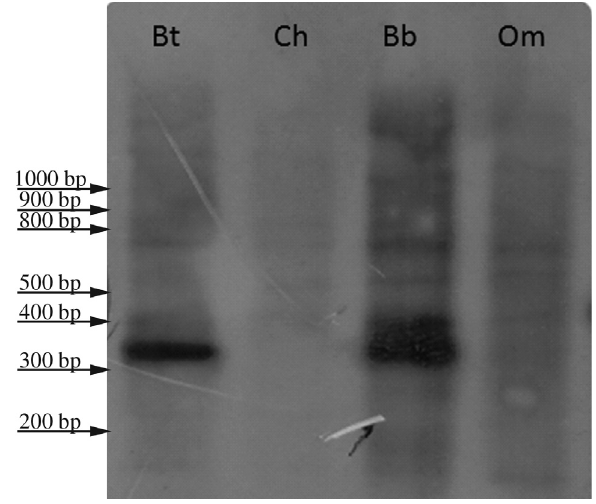
Figure 1 - Bos taurus genomic DNA digested with Hae III and hybridized to probe Bt1. Signals are detected in genera Bos and Bison , but not in gen- era Ovis and Capra . Bt = Bos taurus , Ch = Capra hircus , Bb = Bubalus bubalis , Om = Ovis orientalis